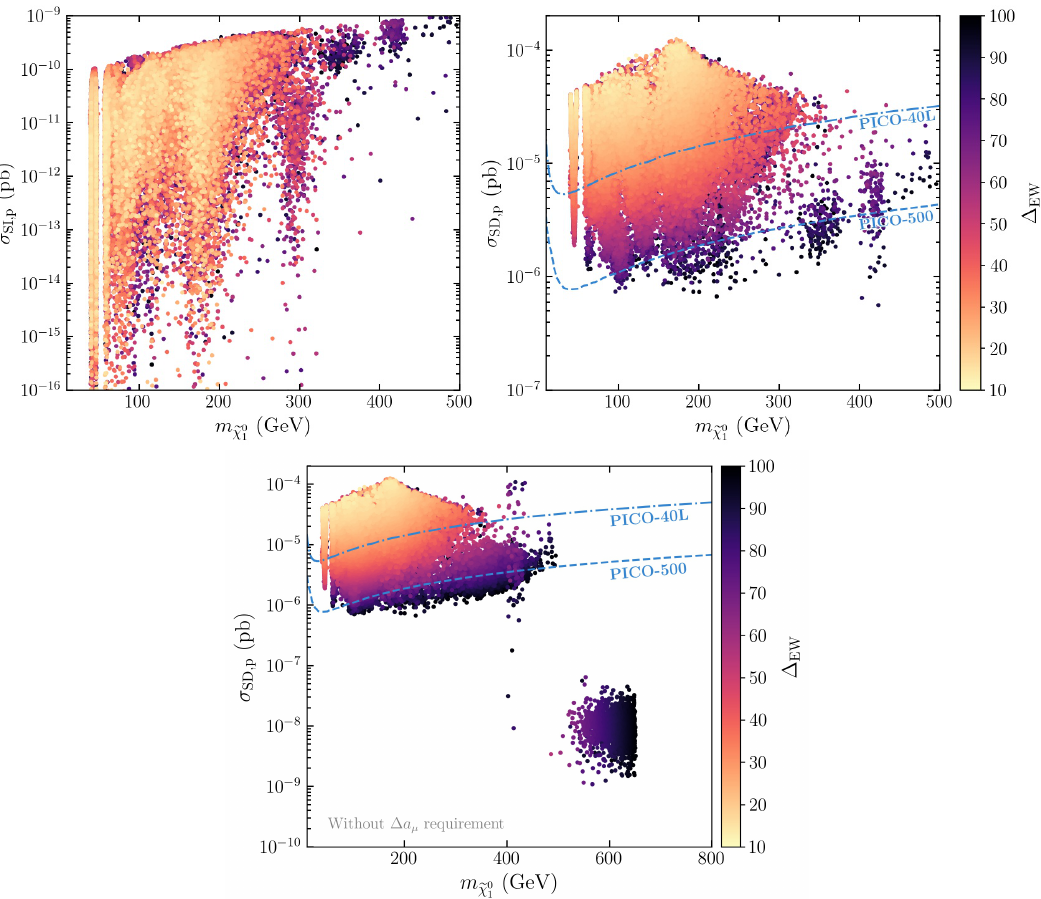
Figure 6: Top right (left): The mass of the DM particle versus the spin-(in)dependent cross section σ ( σ ). The value of ∆ is shown in color code. We also show SD,p SI,p EW [ 142 ] . The points are the projected PICO-40L and PICO-500 central limits on σ SD,p ordered such that those with lower values of ∆ lie on top of those with higher EW values. Bottom: The mass of the DM particle versus σ for spectra satisfying all SD,p constraints listed in Section 3 except the ∆ a µ requirement. This plot contains the data of the present study combined with that from Ref. [ 64 ] , where the requirement on a µ was not taken into